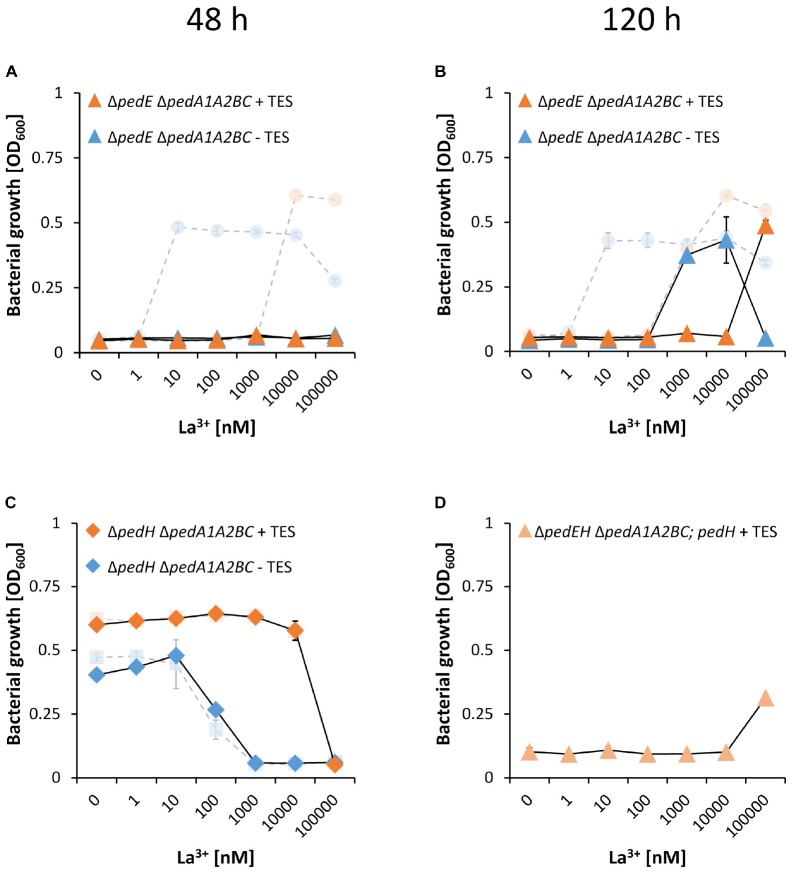
Growth of strains ΔpedEΔpedA1A2BC (A,B, triangles) and ΔpedHΔpedA1A2BC (C, diamonds) in liquid M9 medium on 5 mM 2-phenylethanol with (orange) or without (blue) TES and various concentrations of La3+. Pale circles and squares represent the growth of ΔpedE and ΔpedH parental strains. Growth of strains ΔpedE and ΔpedH in (A,C) represents the restated data from Figure 1 for better comparability. (D) Growth of strain ΔpedEΔpedHΔpedA1A2BC harboring plasmid pMW10 (light orange triangles) in liquid M9 medium on 5 mM 2-phenylethanol, 20 μg/ml kanamycin, TES and various La3+ concentrations. OD600 was determined upon 48 h (A,C) or 120 h (B,D) of incubation at 30°C and 350 rpm. Data are presented as the mean values of biological triplicates, and error bars represent the corresponding standard deviations.